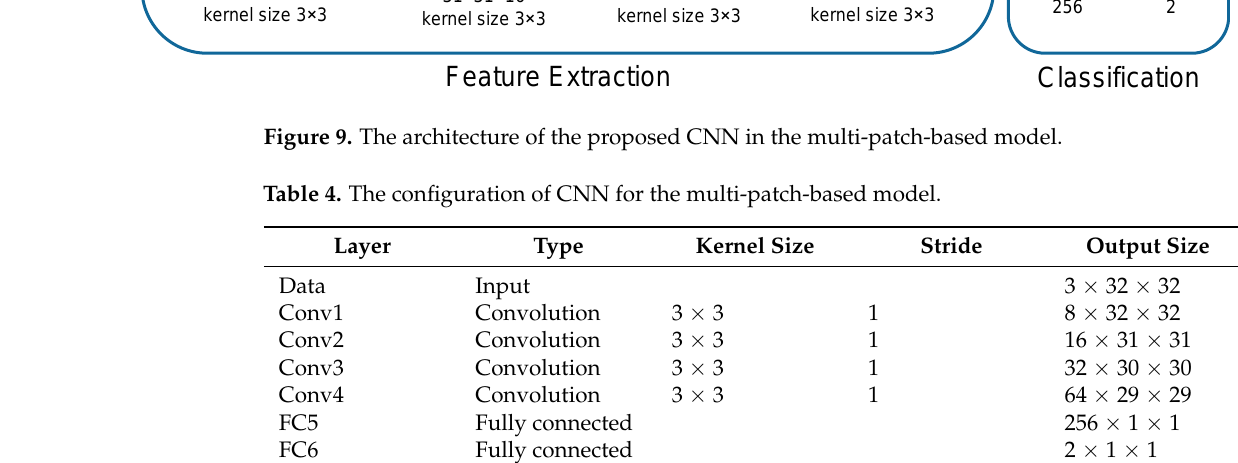
FC5 Fully connected 256 × 1 × 1 FC6 Fully connected 2 × 1 × 1